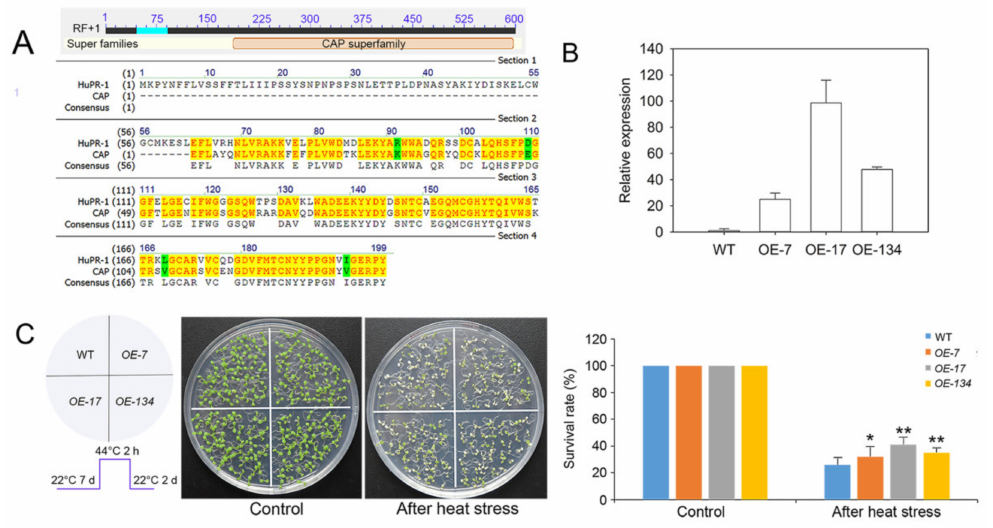
Figure 8. Sequence analysis of HuPR-1 and its overexpression conferred heat tolerance to transgenic Arabidopsis plants. ( A ) Protein sequence alignment result of HuPR-1 in NCBI and protein alignment by Vector NTI Advance 11. ( B ) The qRT-PCR was used to measure the expression levels of HuPR-1 in transgenic Arabidopsis plants. ( C ) Survival rates (%) of WT and transgenic seedlings after heat treatment. Seven-day-old seedlings were heat-treated at 44 ◦ C for 2 h and returned to 22 ◦ C to grow for 2 days, and then photographed; following this, the survival rates were calculated. More than 50 plants of each line were analyzed. Bars represent standard deviations. Asterisks indicate statistically significant differences compared with wild type by Student’s t -test (* p < 0.05, ** p <